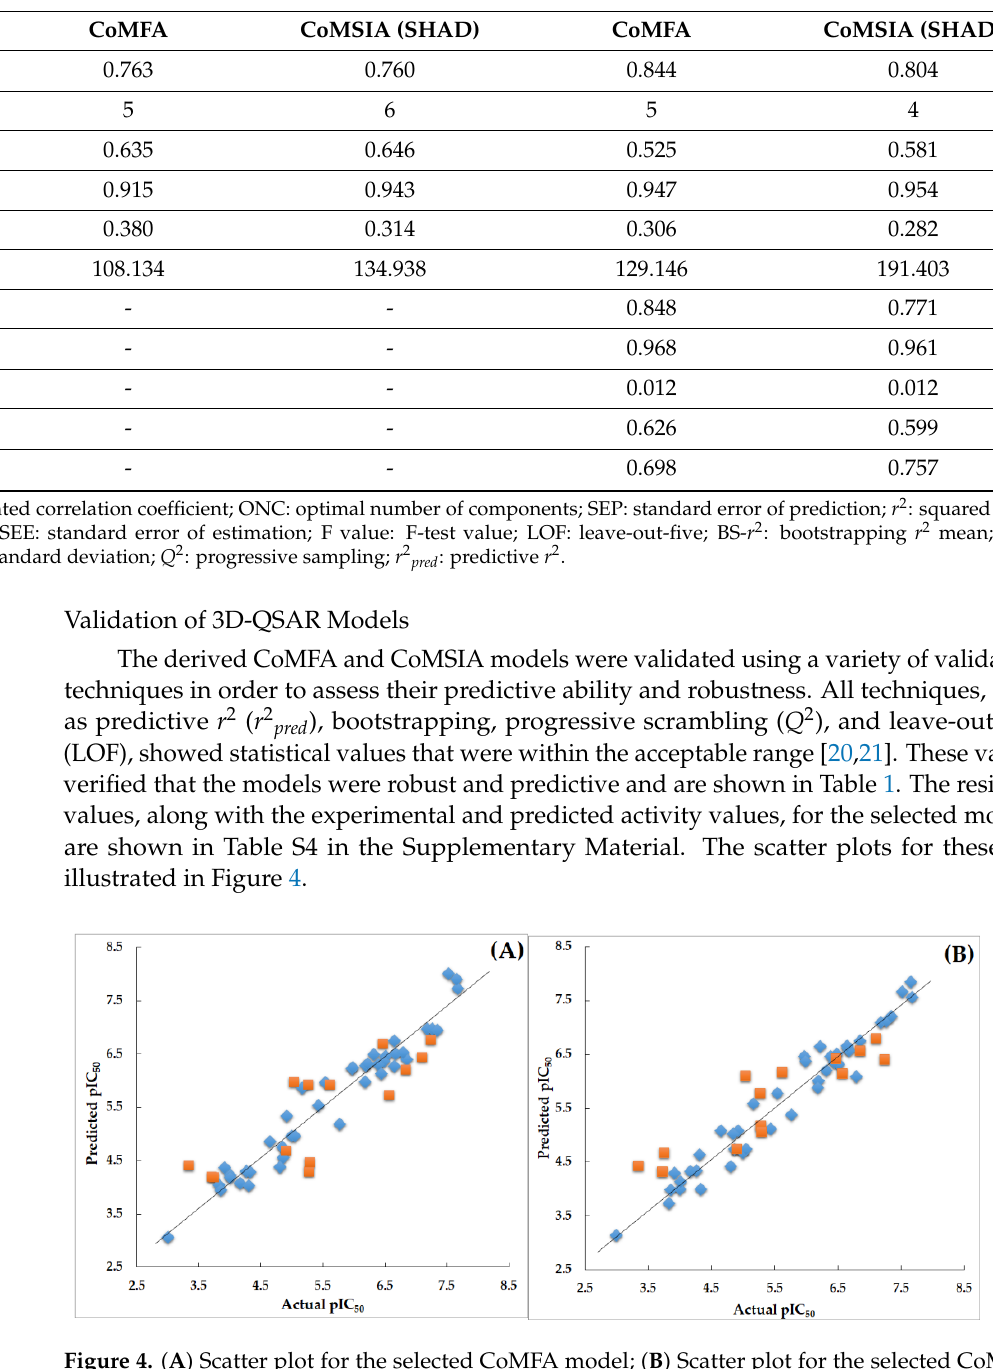
Table 1. Detailed statistical values of the selected CoMFA and CoMSIA models.